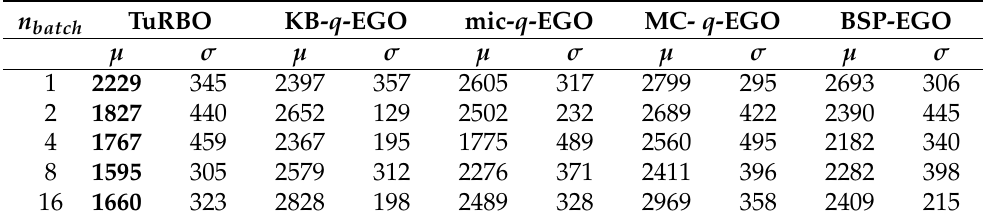
Table 6. Final results in terms of average ( µ ) and standard deviation ( σ ) over 10 execution of each algorithm for the Schwefel benchmark